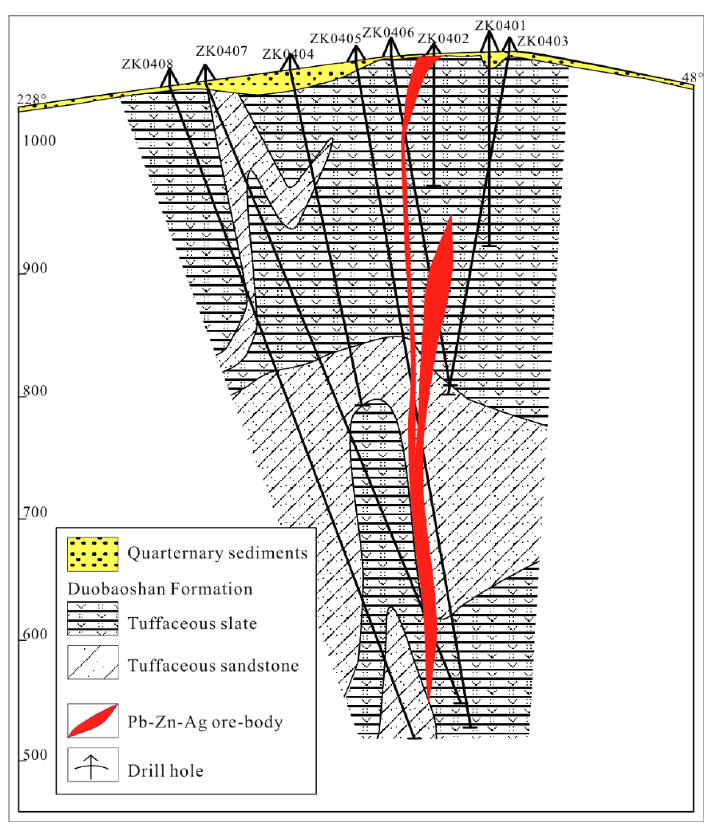
Figure 5. Geological profile of exploration line 04 for Pb-Zn vein ores in the Diyanqinamu mine (modified from [29]).